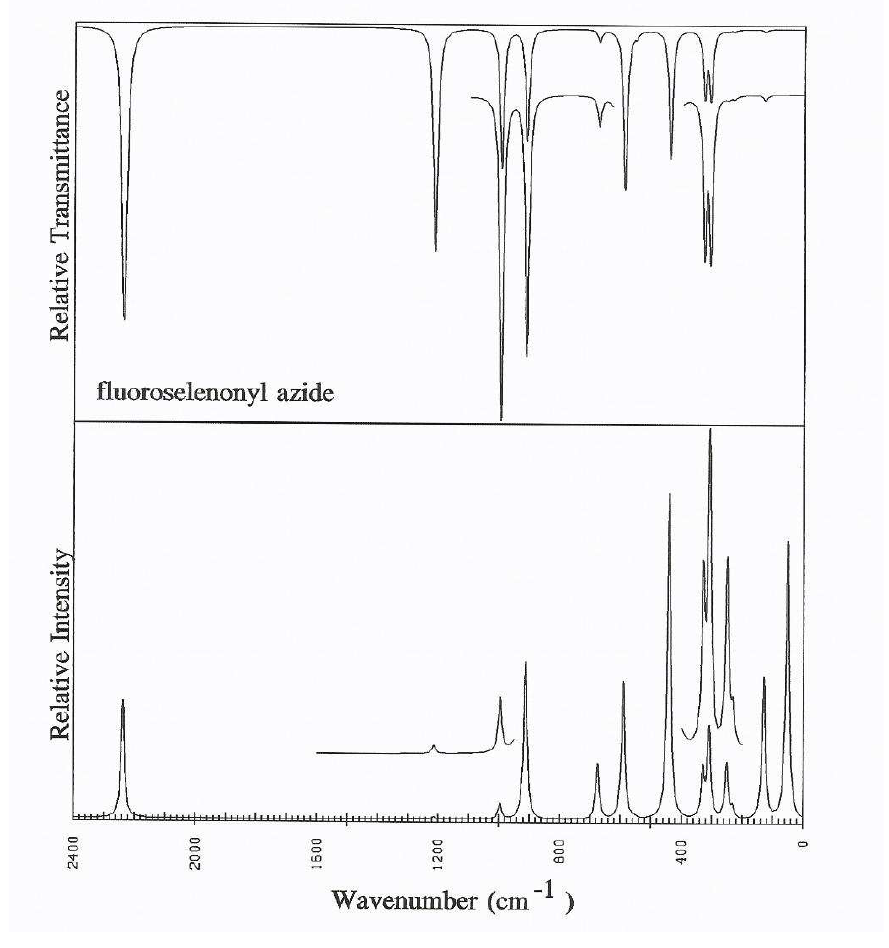
Figure 3 : Calculated vibrational infrared (upper panel) and Raman (lower panel) spectra for the gauche fluoroselenonyl azide at the DFT-B3LYP/6-311+G**